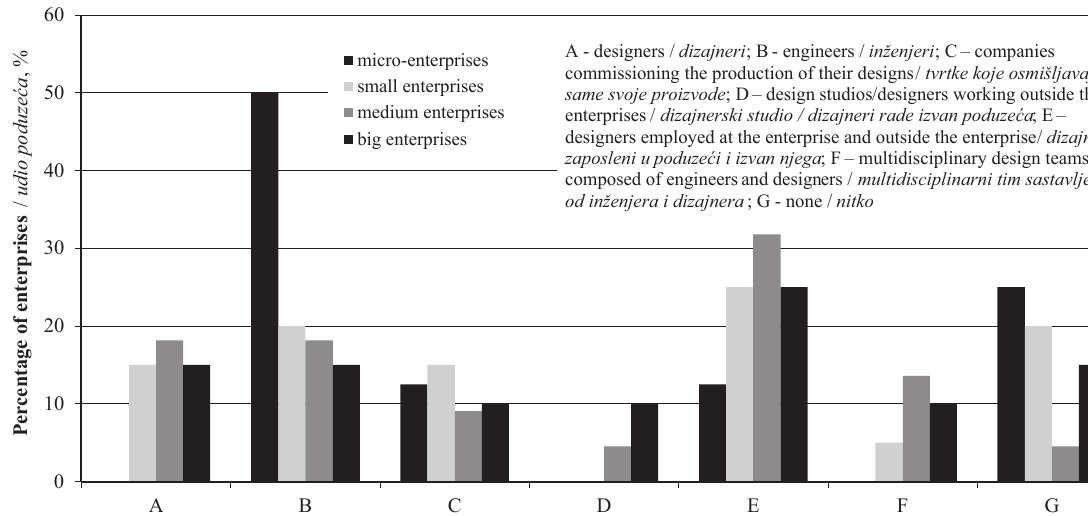
Figure 5 Structure of analysed furniture enterprises depending on the size of the enterprise and the type of design activity the enterprise plans to develop within 3 years since the period of the study Slika 5 . Struktura analiziranih tvrtki za proizvodnju namještaja ovisno o veli č ini tvrtke i aktivnostima dizajniranja proizvoda koje tvrtka planira pokrenuti unutar tri godine od provedenog